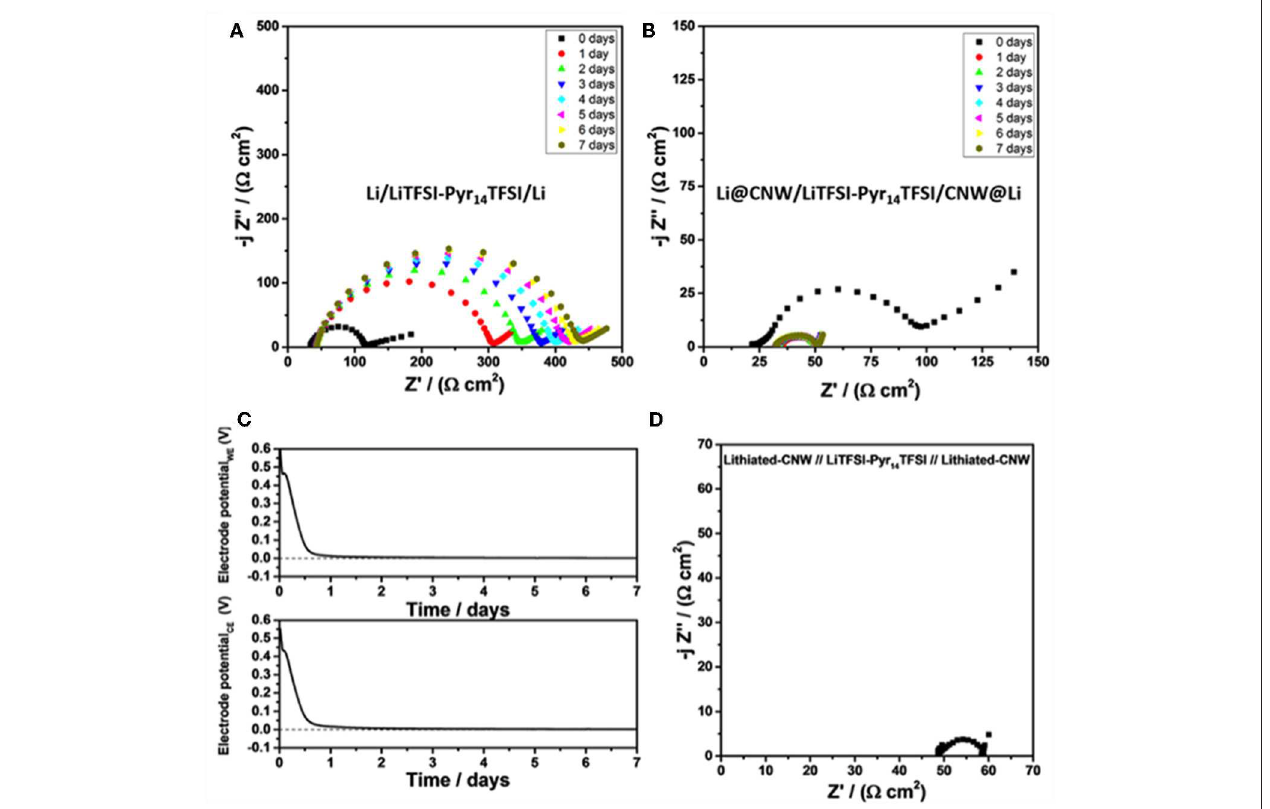
FIGURE 3 | Nyquist plots for the (A) Li/LiTFSI-Pyr 14 TFSI/Li cell and (B) Li@CNW/LiTFSI-Pyr 14 TFSI/CNW@Li cell upon storage in OCV conditions at 20 ◦ C. The corresponding voltage profiles for both Li@CNW electrodes in the Li@CNW/LiTFSI-Pyr 14 TFSI/CNW@Li cell are shown in (C) ; a lithium metal quasi-reference was used for this experiment. (D) The Nyquist plot for the CNW Li /LiTFSI-Pyr 14 TFSI/CNW Li cell at 20 ◦ C (the CNW electrodes were prelithiated by contact with Li metal in presence of the electrolyte to favor Li + ion mobility). Please note the different scales for the three Nyquist